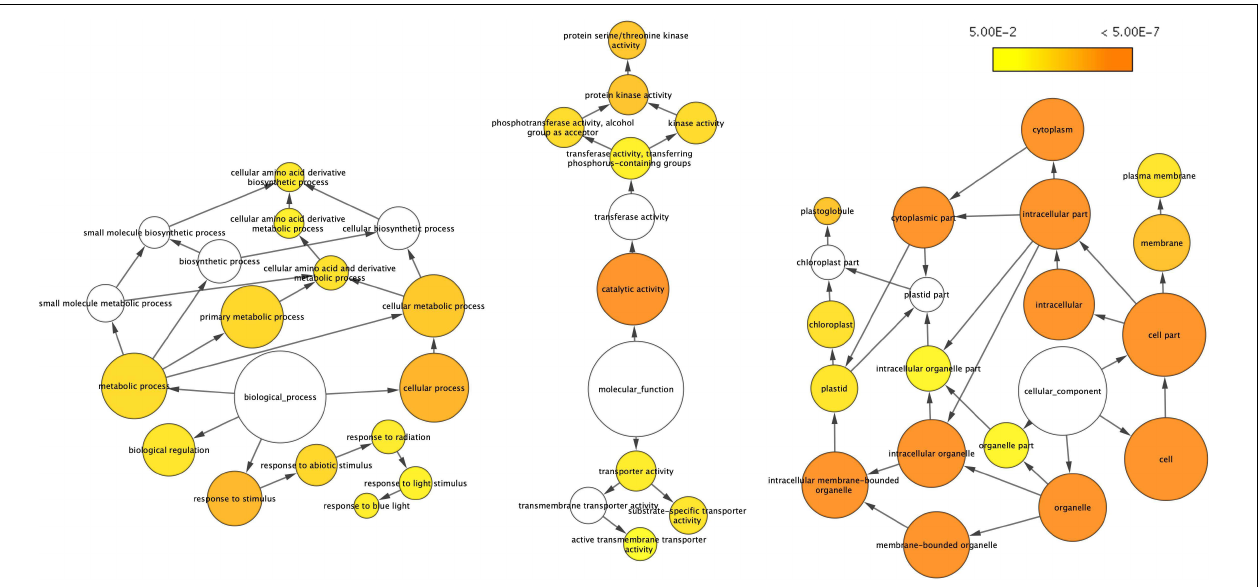
FIGURE 3 | Gene networks of differentially expressed transcripts (DETs) identified from the leaves of the 83-day old plants. The ontology file of GOSlim_Plants in BiNGO was used to identify overrepresented GO terms ( p < 0.05). Bubble size and color indicate the frequency of the GO term and the P -value,